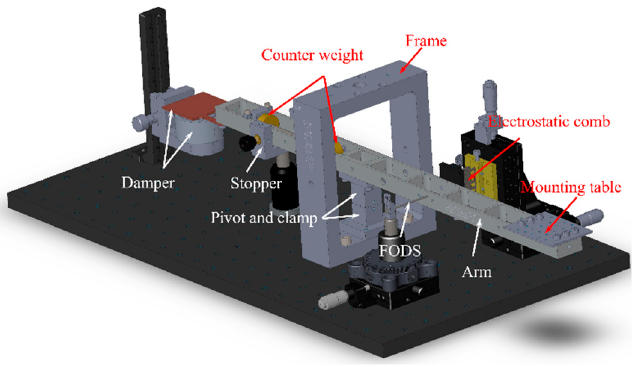
Figure 1. Schematic of the torsional thrust balance.